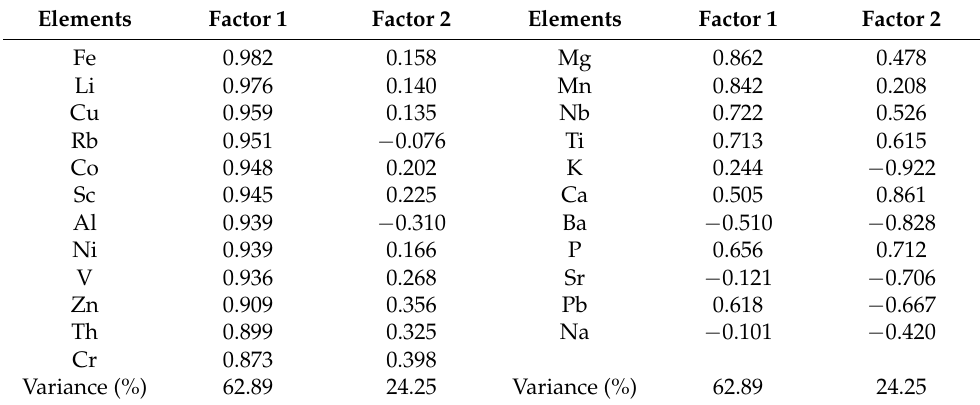
Table 5. Results of factor analysis (n =